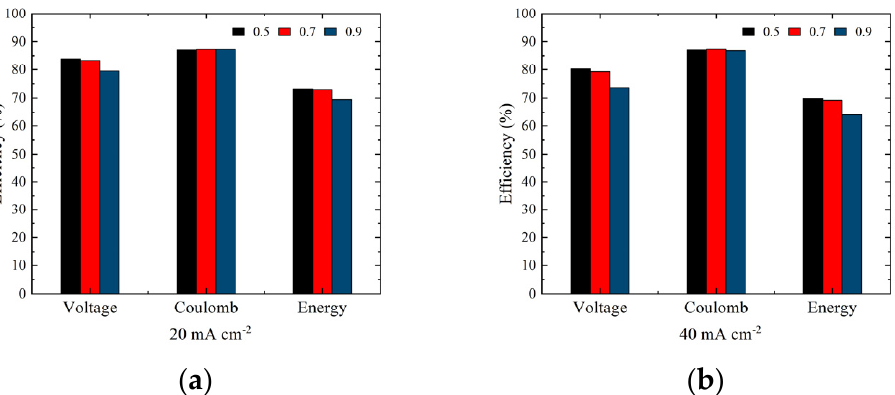
Figure 13. Voltage, coulomb, and energy efficiency of battery with different electrode porosities at current densities of ( a ) 20 mA cm − 2 and ( b ) 40 mA cm − 2 . Table 6. Discharge capacities of battery with different electrode porosities at different current densities (Ah).